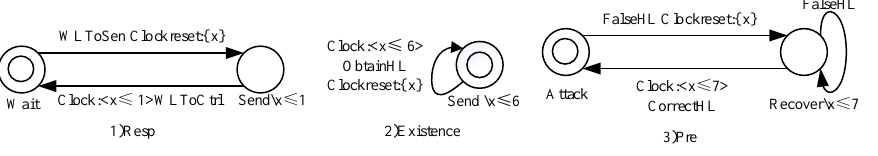
Figure 11. Property models of the